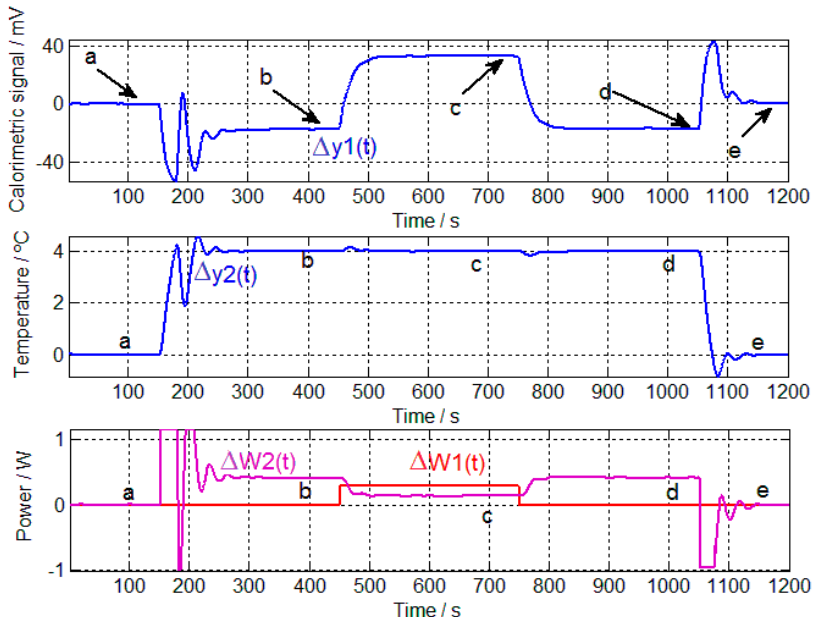
Figure 3. Calibration measurements after correcting the baselines, including calorimetric signal ∆ y 1 ( t ), thermostat temperature ∆ y 2 ( t ), power dissipated in the resistor placed on the calibration base ∆ W 1 ( t ) and power dissipated in the thermostat ∆ W 2 ( t ). The five steady states are indicated ( a – e ).